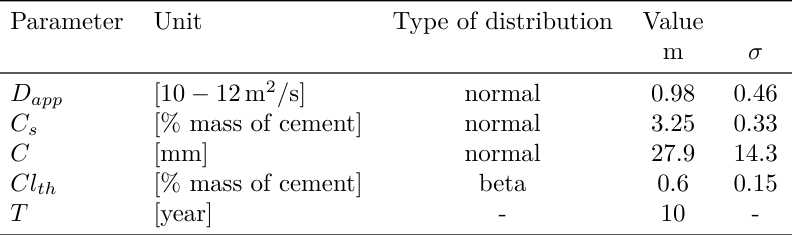
Table 4. Values of the parameters and types of statistical distribution used as inputs in the probabilistic approach ( m = mean value, σ = standard